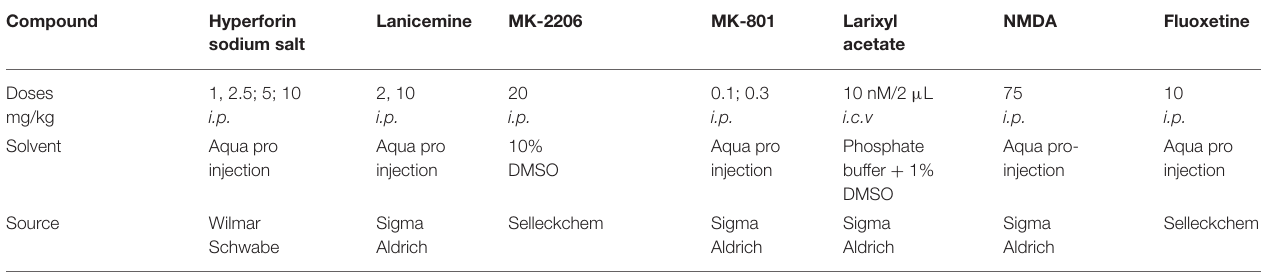
TABLE 1 | Pertinent information on the various compounds/drugs. Compound